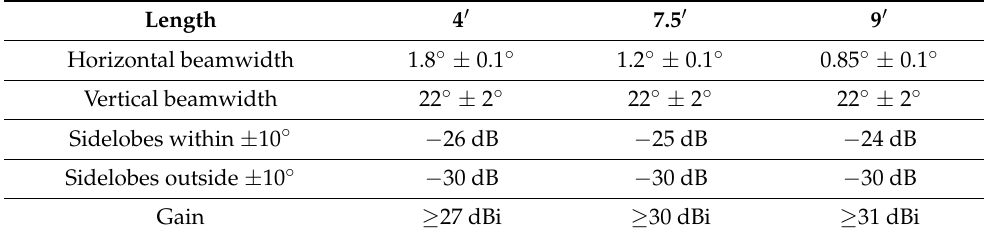
Table 2. Main characteristics of the radar antennas from